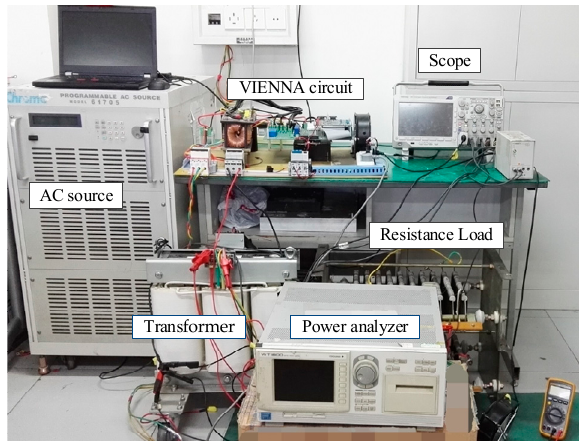
Figure 10. Prototype picture of VIENNA circuit experiment platform.